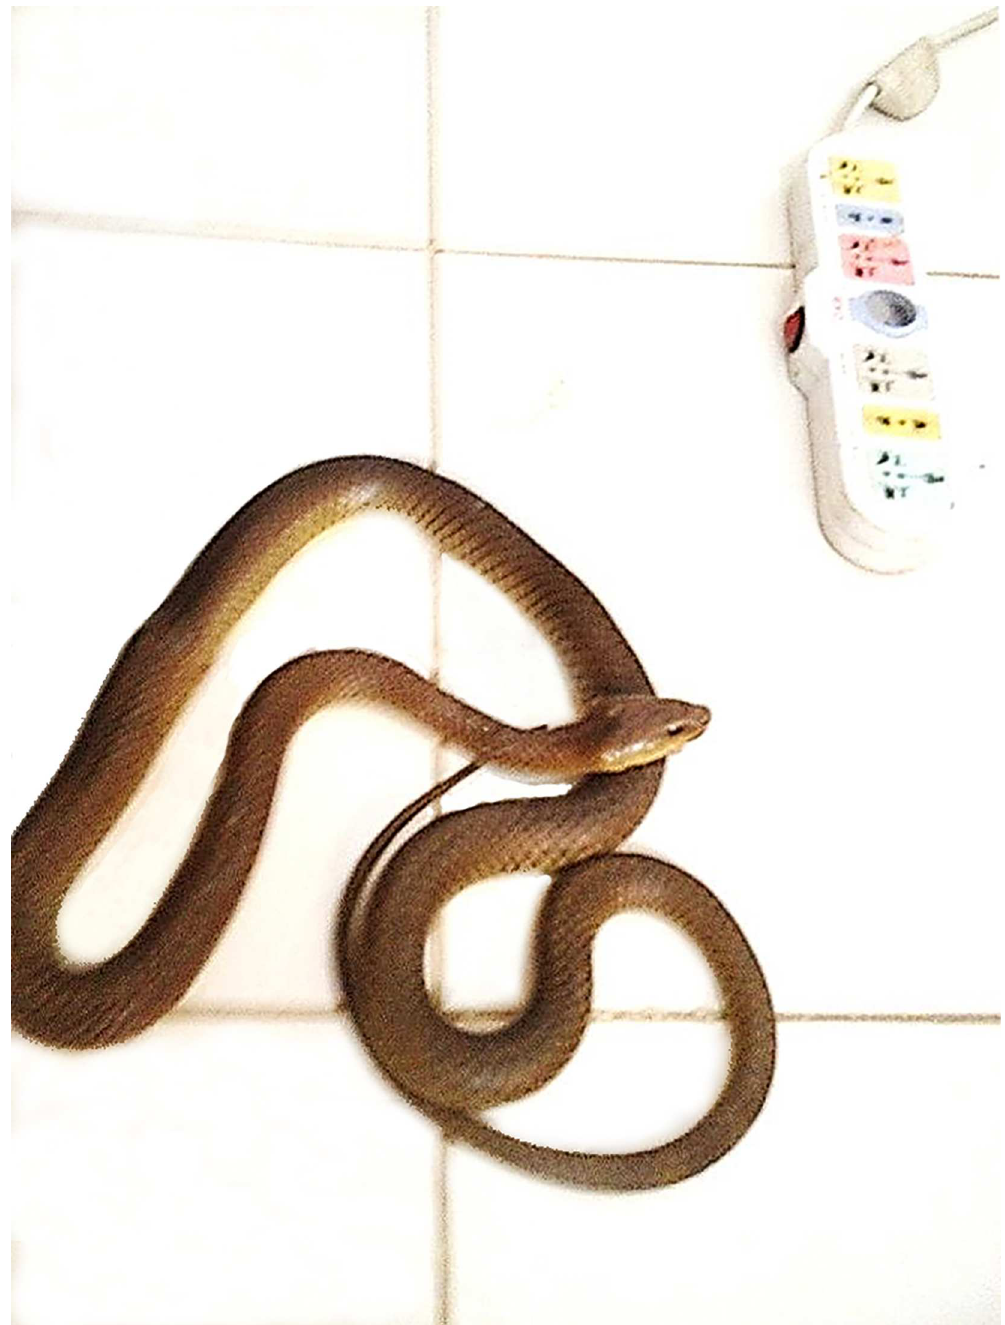
Fig 2. Unexpected visitor during a GCP/GCLP training workshop in Tabarak Allah Health Centre,